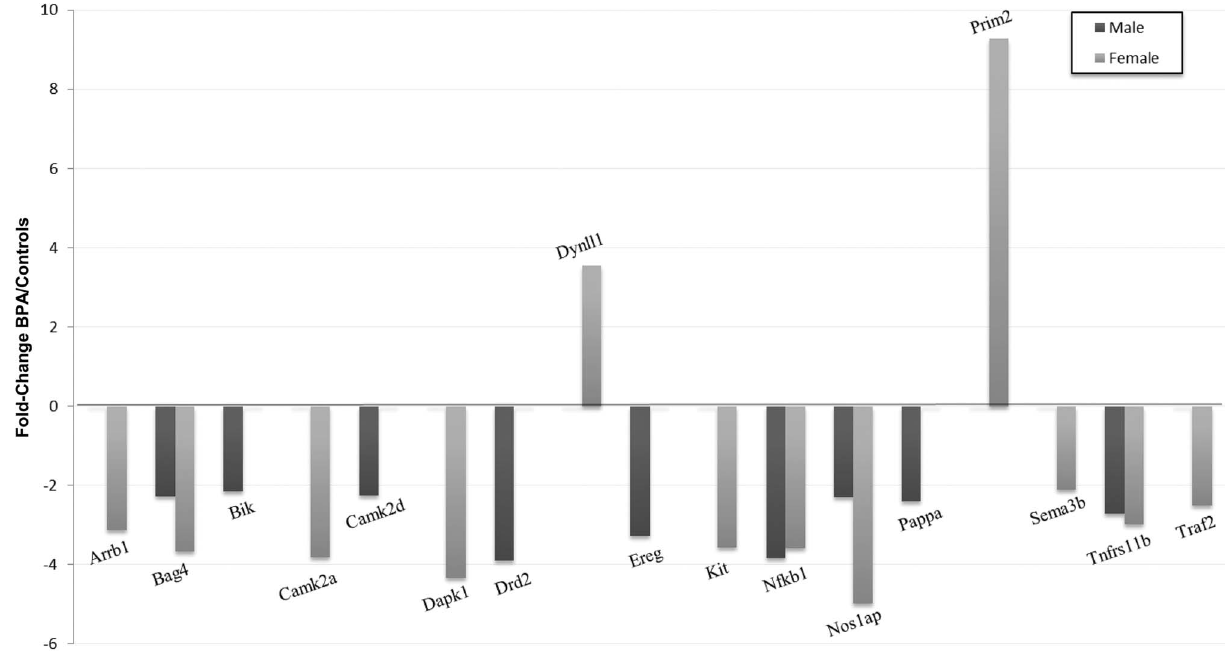
Figure 6. Effects of BPA on relative expression of genes involved in neurotoxic responses in prefrontal cortex of male and female rats. At least p , 0.05 vs. their